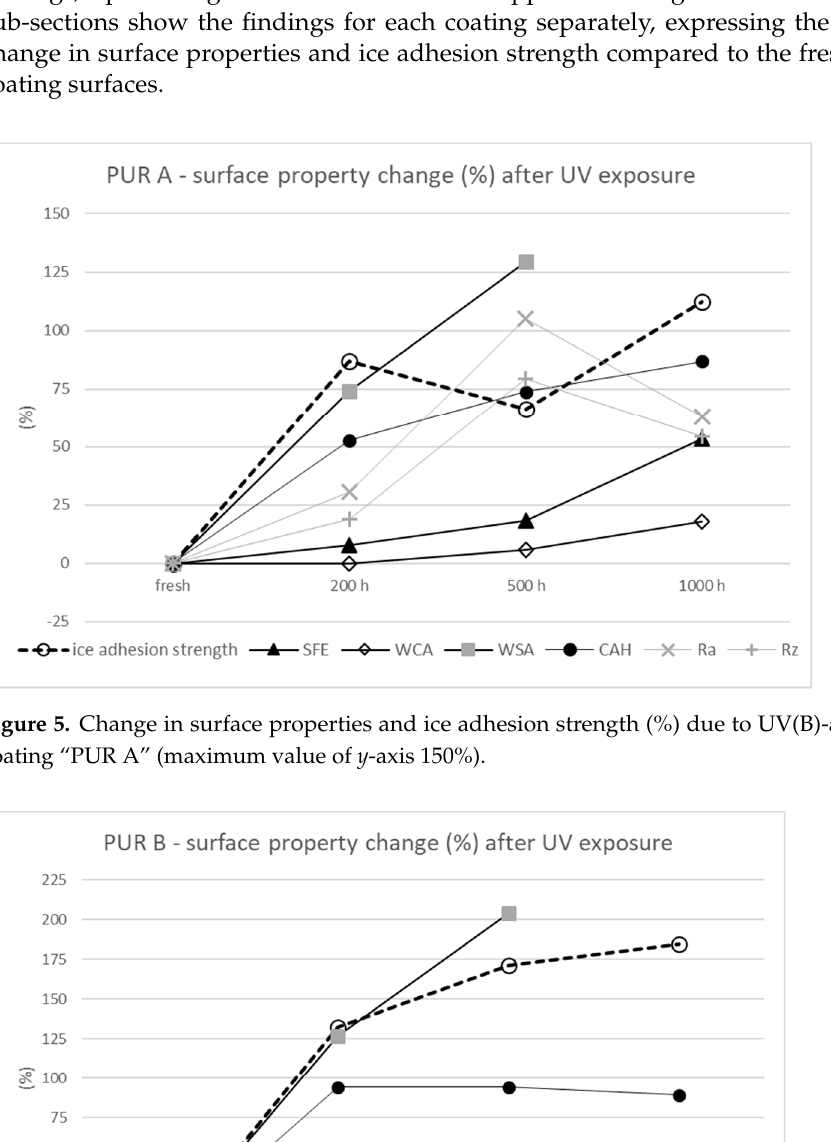
Figure 7. Change in surface properties and ice adhesion strength (%) due to UV(B)-ageing of the coating “PUR C25” (maximum value of y -axis 150%).